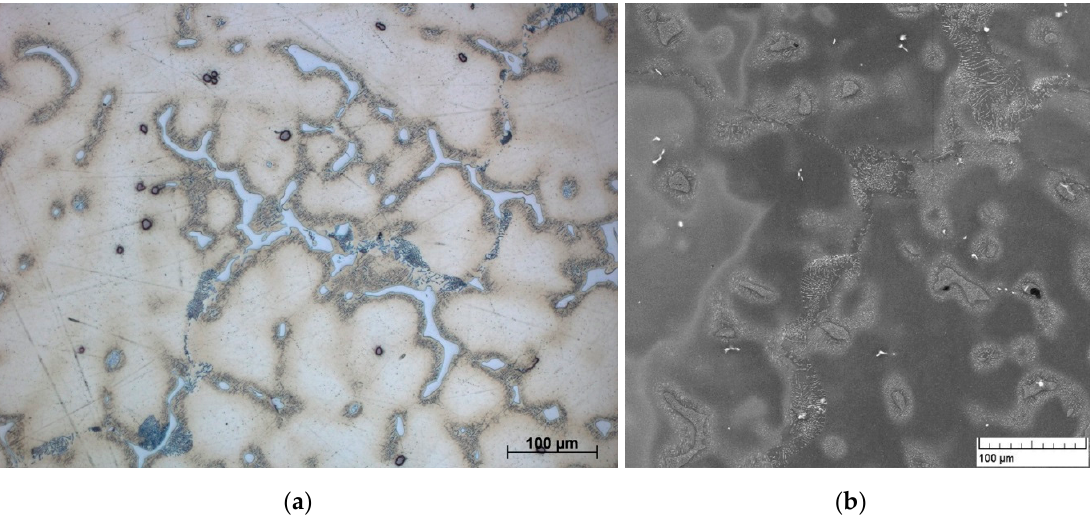
Figure 5. Microstructure of the AZ91 alloy in the initial state. ( a ) Light micrograph. ( b ) Electron micrograph. Picric acid was used for etching.